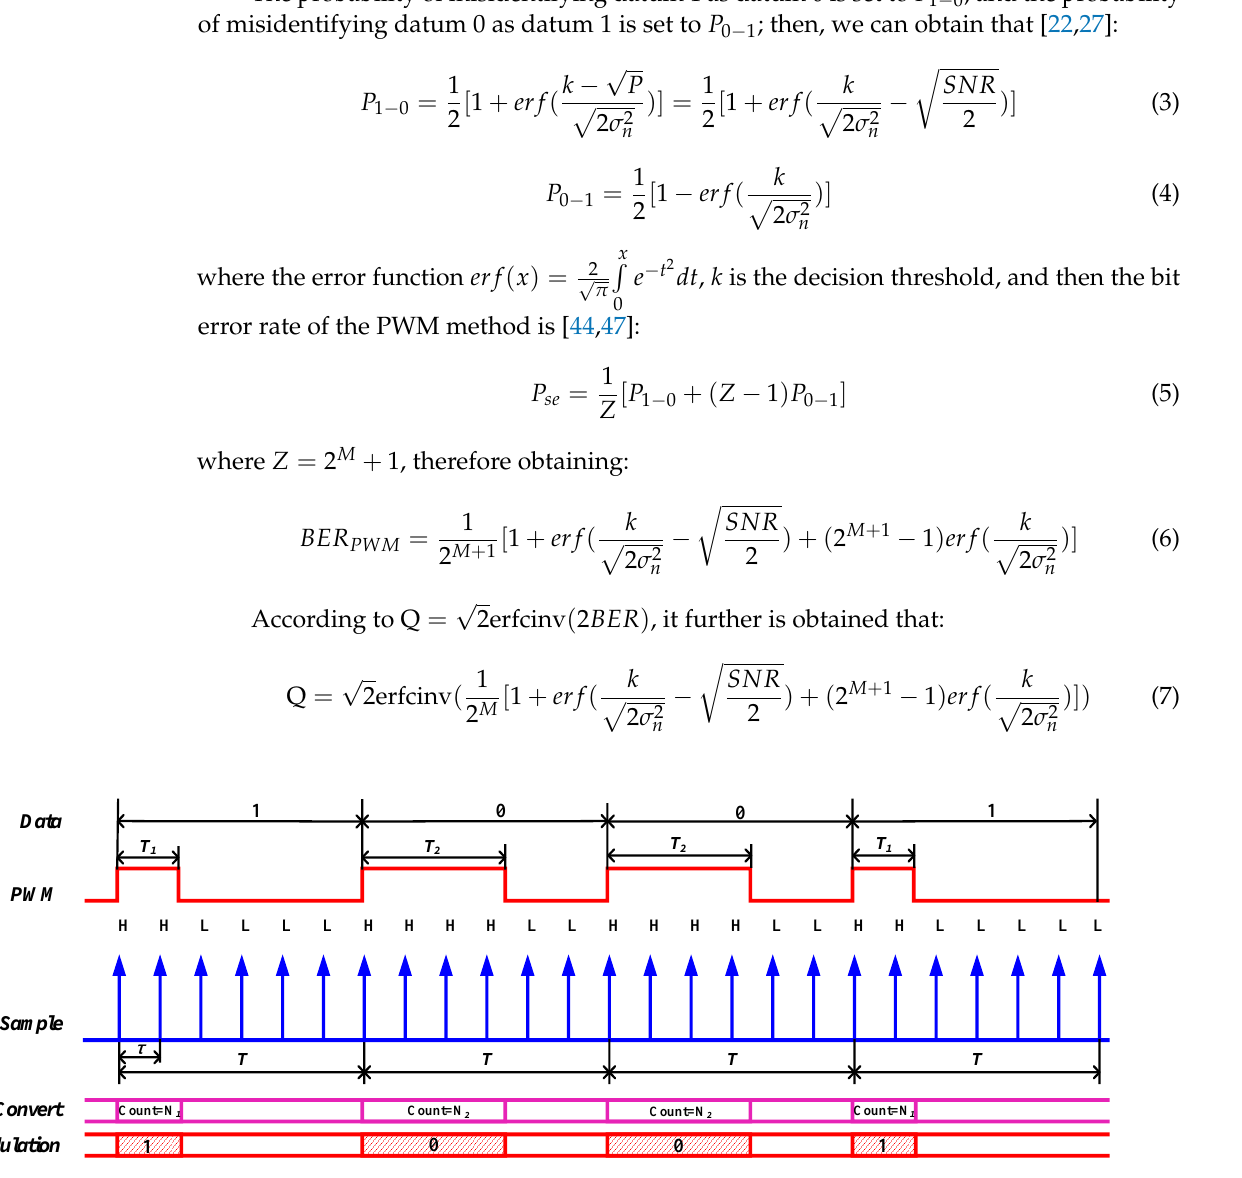
Figure 3. principle of pulse width modulation and demodulation [34]. Figure 3. Principle of pulse width modulation and demodulation